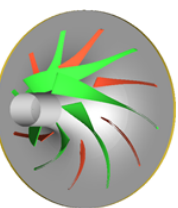
Figure 4: The location and position of the blades on the lower part